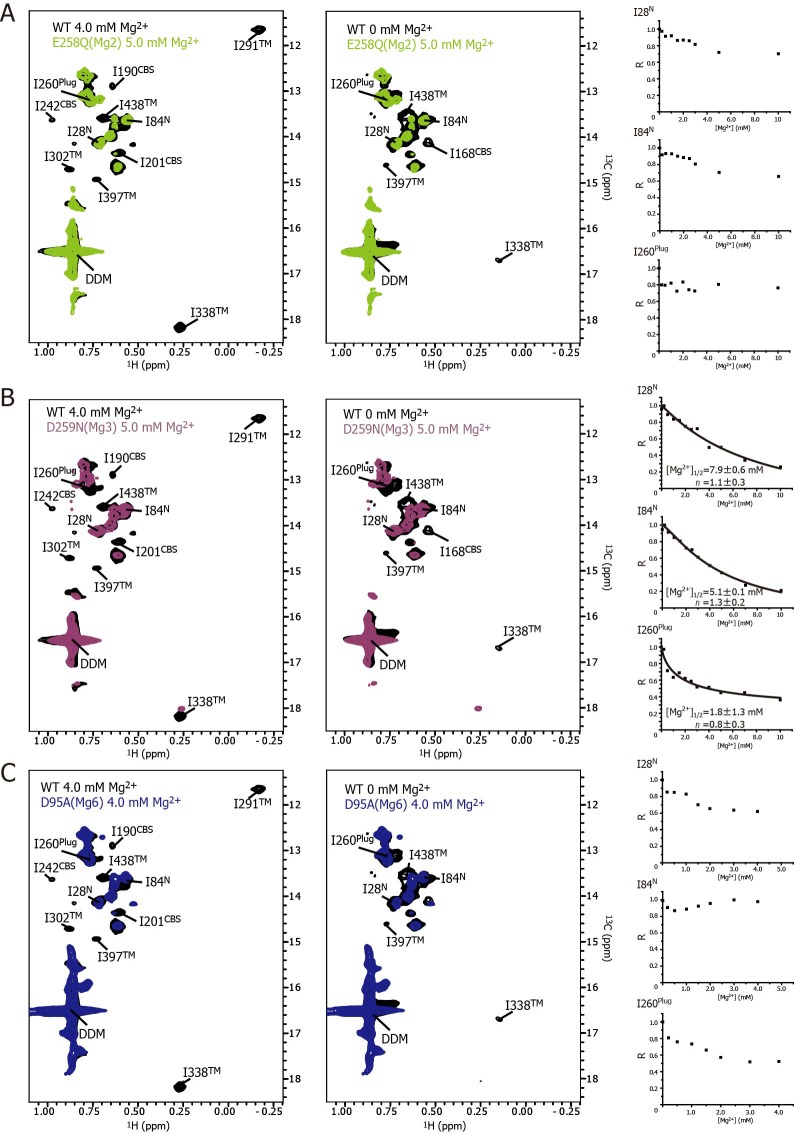
Effects of the mutations at each Mg2+ binding site on the Mg2+-dependent changes in MgtE structure and dynamics.(A–C) Methyl-TROSY spectrum of the E258Q mutant of the Mg2 site in the presence of 5.0 mM Mg2+ (A, light green), the D259N mutant of the Mg3 site in the presence of 5.0 mM Mg2+ (B, purple), and the D95N mutant of the Mg6 site in the presence of 4.0 mM Mg2+ (C, blue) superimposed on the spectrum of the wild-type (WT) protein (black) in the presence (left) and absence (middle) of 4.0 mM Mg2+, respectively. Normalized signal intensities (R) for I28N, I84N, and I260Plug were plotted against Mg2+ concentration ([Mg2+]). The solid lines in (B) represent the best fit curves of a Hill equation to the data. The estimated Mg2+ concentrations reaching half maximal values of the changes ([Mg2+]1/2) and the Hill coefficients (n) are shown in the graph.